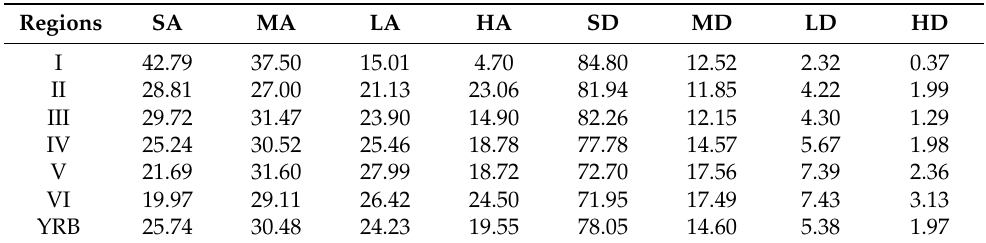
Table 2. Contributions of different categories of precipitation to the total precipitation over the YRB from 1960–2017